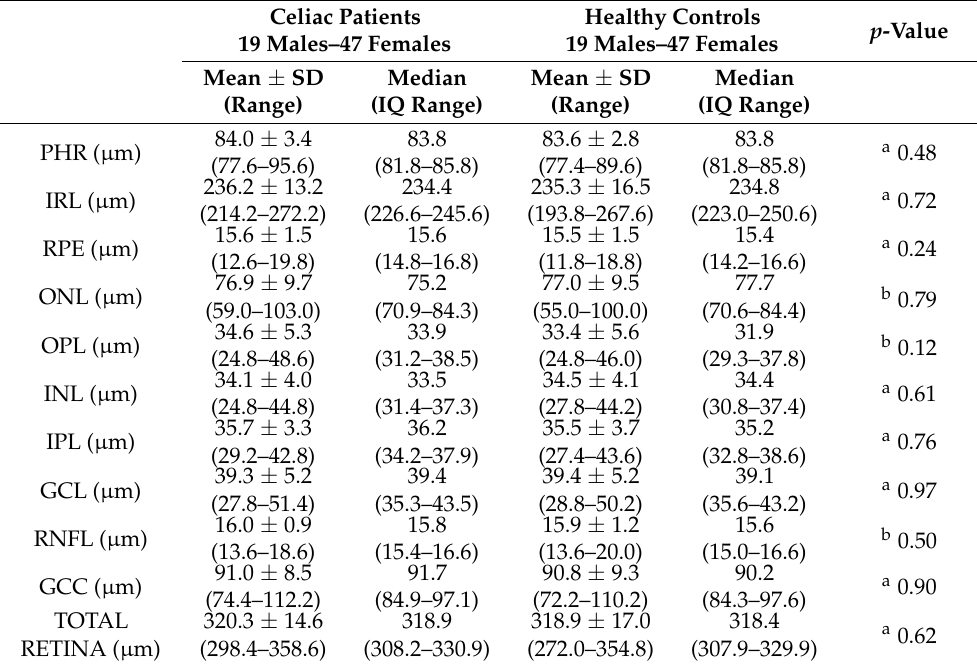
Table 2. Comparison of average retinal layer thicknesses ( µ m) between celiac patients and healthy subjects at 2 mm diameter of ETDRS grid on